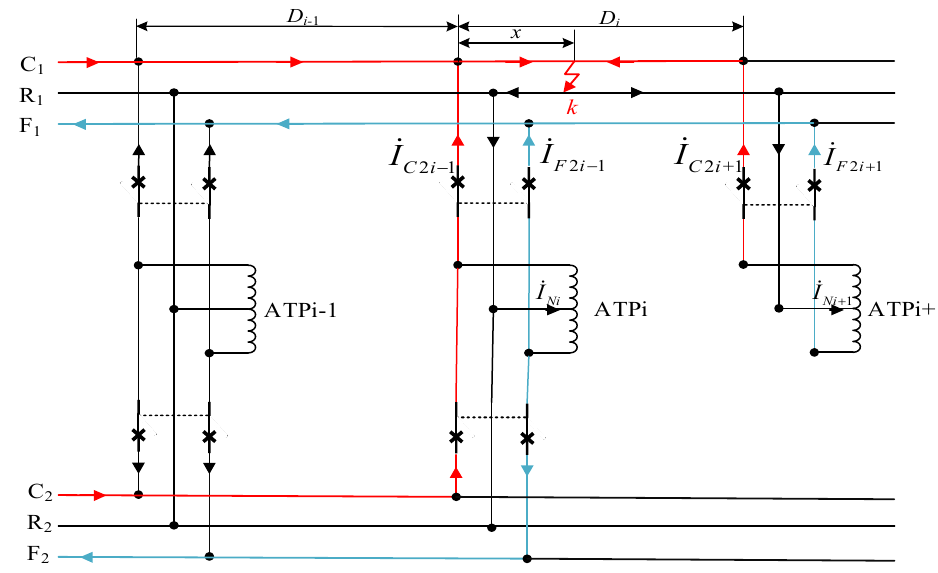
Figure 3. Current distribution in a single-line AT (SLAT) feeding condition.